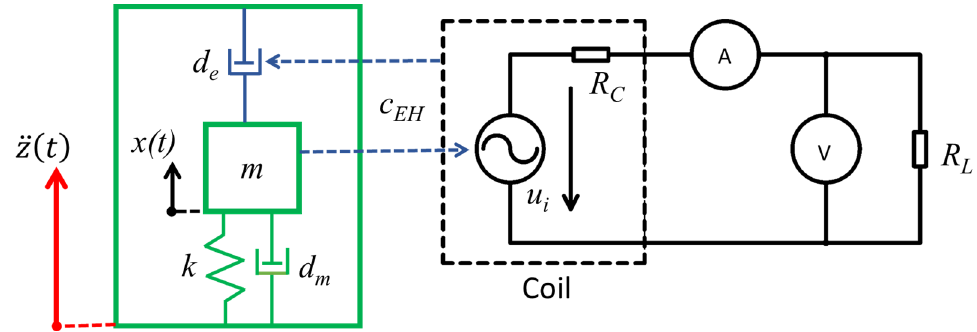
Figure 2. Coupled mechanical and electromagnetic models of the proposed kinetic energy har- vester.